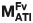
Coefficient of variation (CoV; standard deviation/mean*100%) of the half-sarcomere lengths during an isometric contraction at muscle length L/L0 = 1.2, for models MATIFv (blue line), MFv (red line), MATI (black solid line) and Mxx (black dashed line).While actin—titin interactions can damp the magnitude of half-sarcomere—length heterogeneities, the force-velocity relation damps the their temporal evolution.